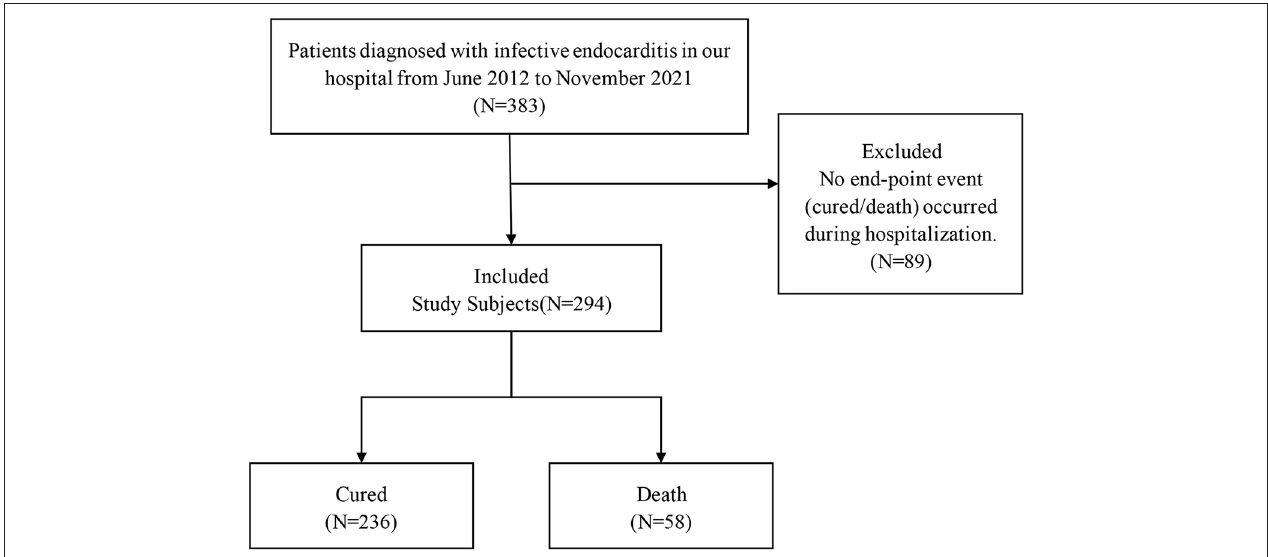
FIGURE 1 | Study enrollment flowchart.